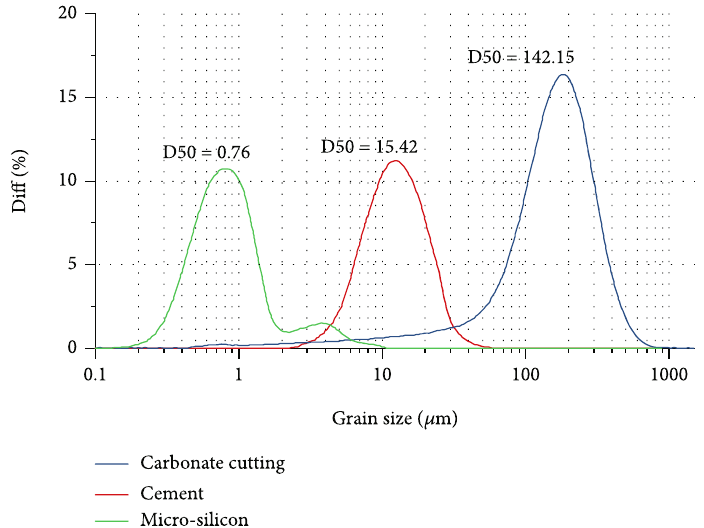
Figure 1: Particle size distribution of the three solid-phase